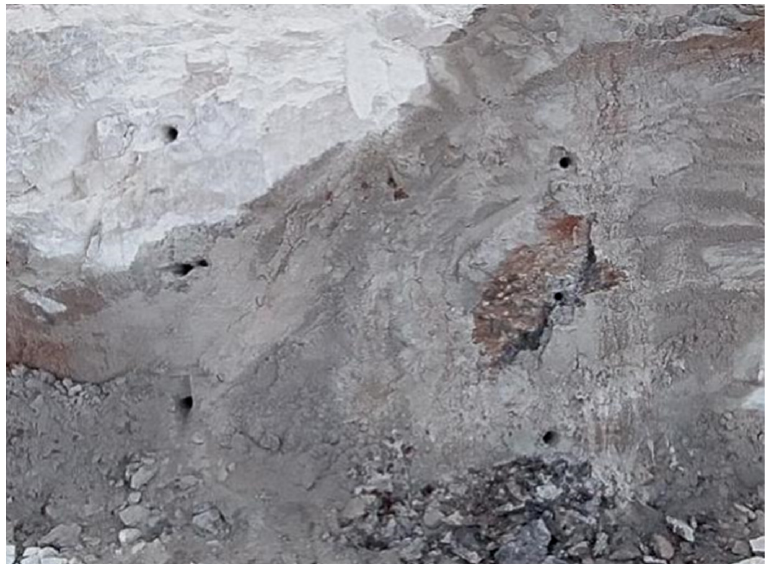
Figure 9. Rock vertical slope used for a cutting blasting experiment.